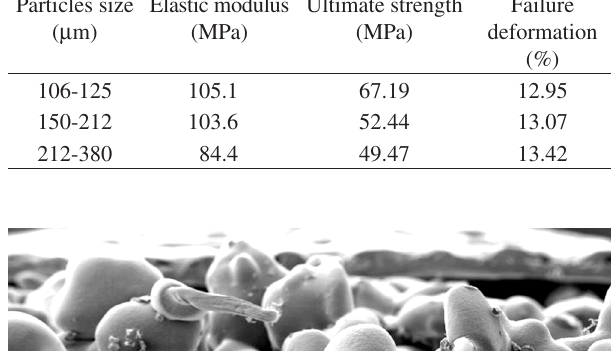
Table 1. Values of theoretic, volumetric and apparent density of the HDPE specimens prepared with different particles size. Particle size